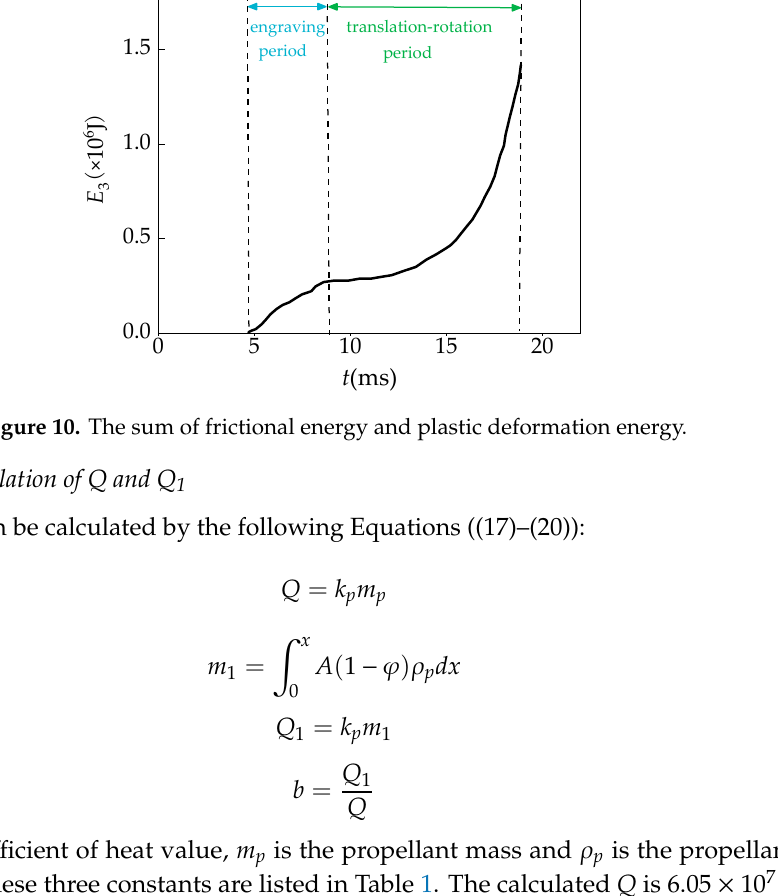
Figure 9. Mises stress and morphology at 9.5 ms in the translation-rotation period.